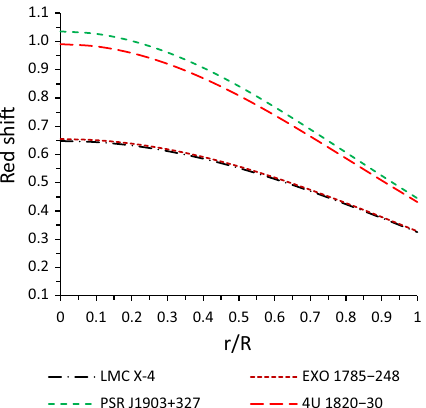
Fig. 7 Variation of redshift ( Z ) with the fractional coordinate r / R . For plotting this figure the numerical values of the physical parameters and constants are as follows: (i) a = 0 . 004, b = 0 . 0021, c = 0 . 0107, A = 0 . 4806, B = 1 . 2607, M = 1 . 29 M (cid:7) , and R = 8 . 831 km for LMC X-4, (ii) a = 0 . 00393, b = 0 . 0025, c = 0 . 01074, A = 0 . 4905, B = 1 . 2293, M = 1 . 3 M (cid:7) and R = 8 . 849 km for EXO 1785-248, (iii) a = 0 . 005, b = 0 . 0004, c = 0 . 01481, A = 0 . 4654, B = 1 . 0551, M = 1 . 667 M (cid:7) and R = 9 . 438 km for PSR J1903+327, (iv) a = 0 . 0055, b = 0 . 0002, c = 0 . 0155, A = 0 . 44506, B = 1 . 1286, M = 1 . 58 M (cid:7) and R = 9 . 1 km for 4U 1820-30